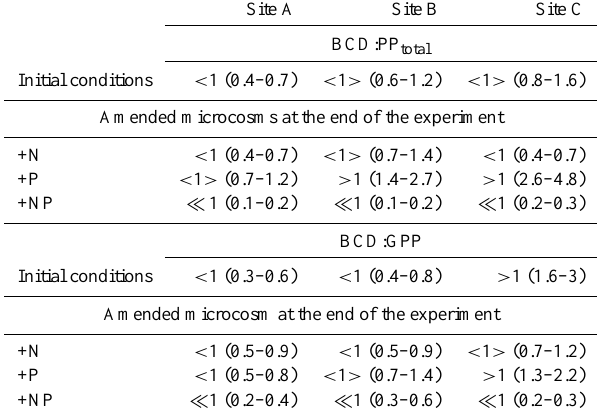
Table 4. Ratios of the bacterial carbon demand to total primary production (BCD:PP total ) , for the initial conditions, and at the end of the experiment, in the microcosms amended with nitrogen (+N), phosphorus (+P), and nitrogen plus phosphorus (+NP) additions. GPP was converted to carbon units applying a photosynthetic quo- tient (PQ) of 1.1 (Laws, 1991). BCD:GPP = Mean ratios of the bacterial carbon demand to gross primary production (GPP) for the same samplings. Within the parenthesis the lower value in each case the dark community respiration (BCD 50 = BP+DCR/2) while the higher value is based on the assumption that bacterial respiration equals dark community respiration (BCD 100 =